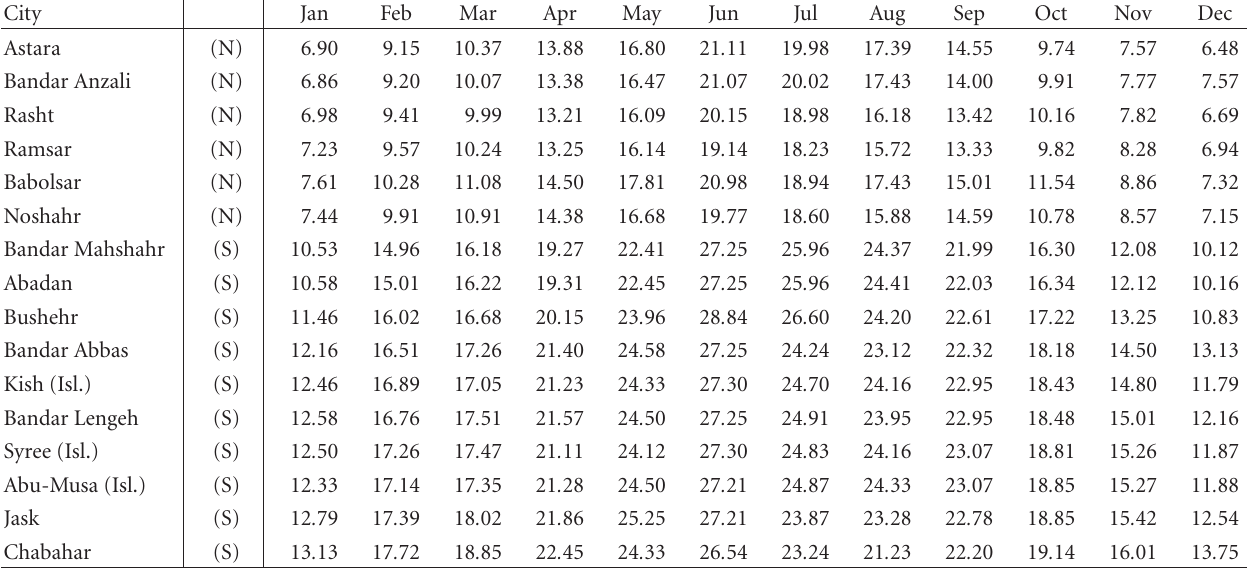
m (cid:3) 2 day (cid:3) 1 (cid:2) ) predicted by (MD) method. (cid:2) (cid:2)